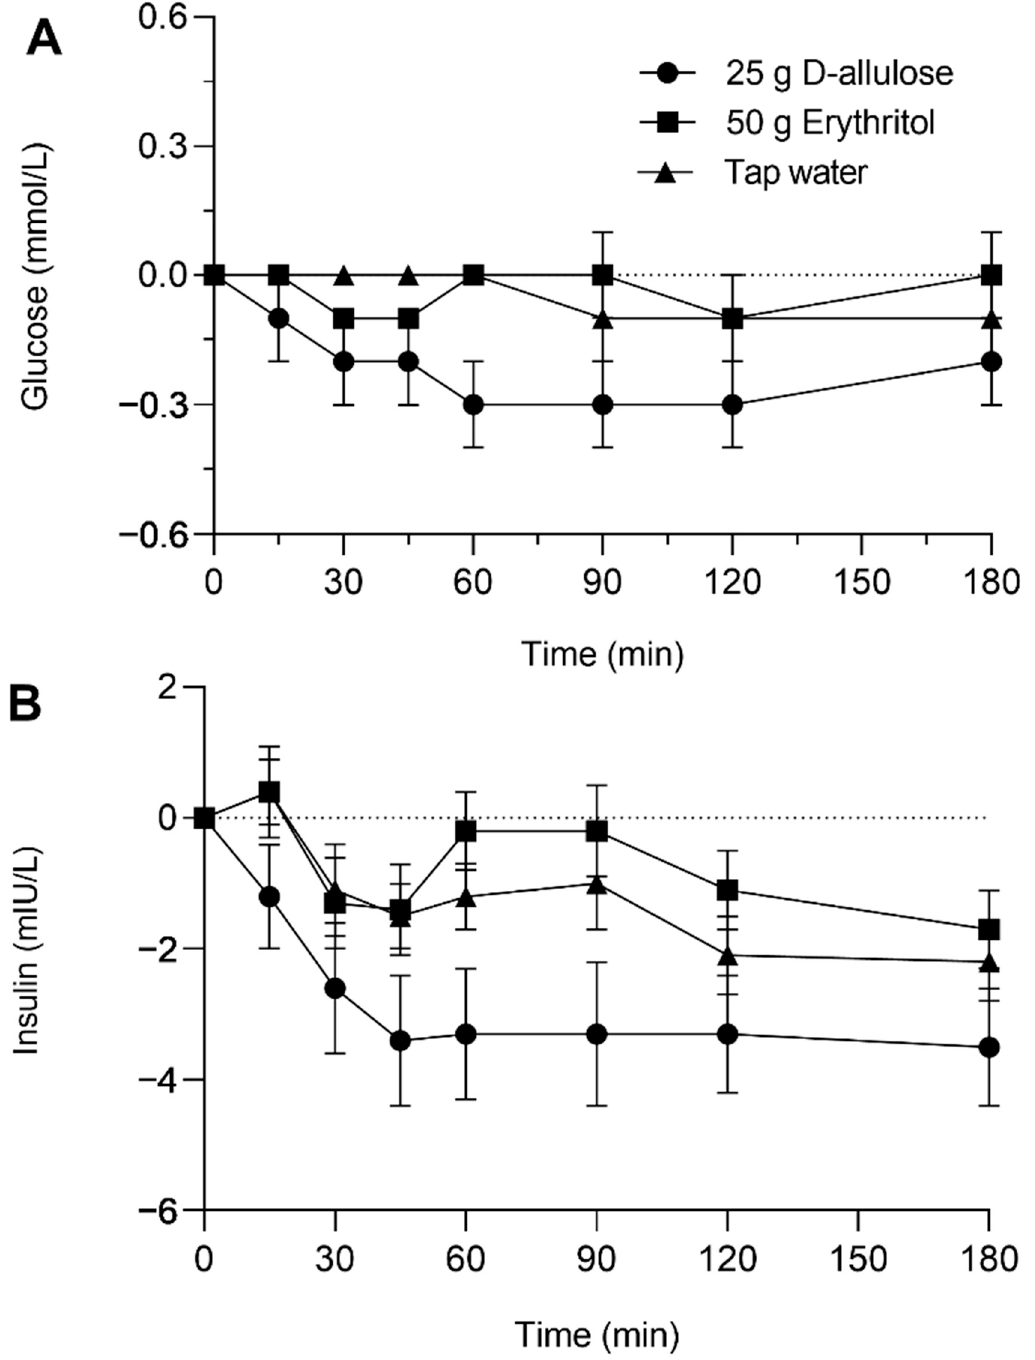
Figure 2. Glucose ( A ) and insulin ( B ) concentrations in response to intragastric administration of solutions containing 25 g D-allulose, 50 g erythritol or tap water to 18 healthy subjects. Data are expressed as mean ± SEM, and changes from baseline values are shown. The Bayesian repeated measures ANOVA on the AUC yielded moderate evidence in favor of a difference between the three solutions in the omnibus test (BF 10 = 7.50, R² = 0.42 [0.26–0.57]), as well as for the D-allulose vs. tap water post-hoc comparison (BF 10 = 4.14).